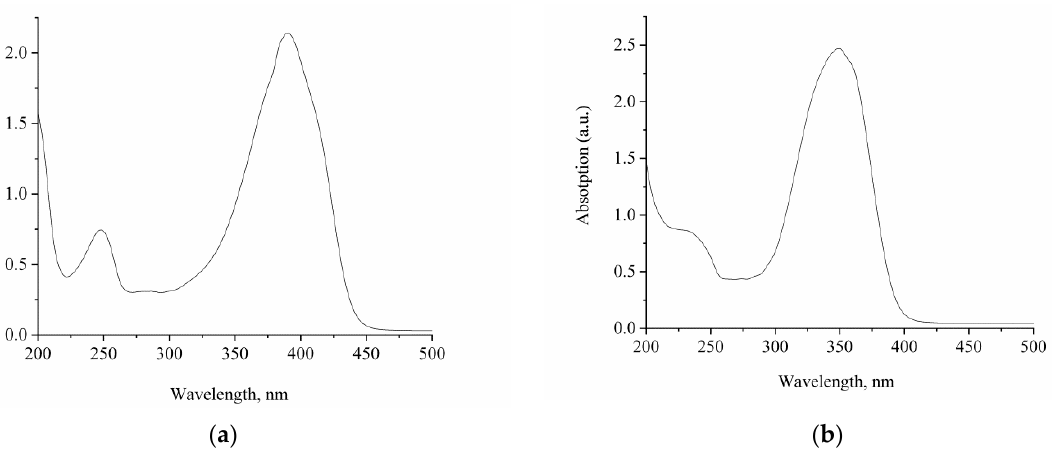
Figure 2. Absorption spectra of compounds ( a ) 1 and ( b ) 2 . The concentration of compounds is 4 × 10 –5 ( a ) and 5 × 10 –5 ( b ) mol/L.